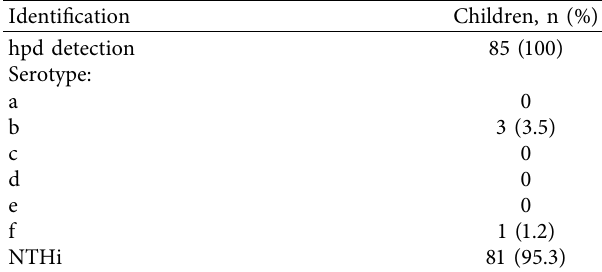
Table 1: Identification and serotyping of 85 H . influenzae strains isolated from nasopharynx of school children with